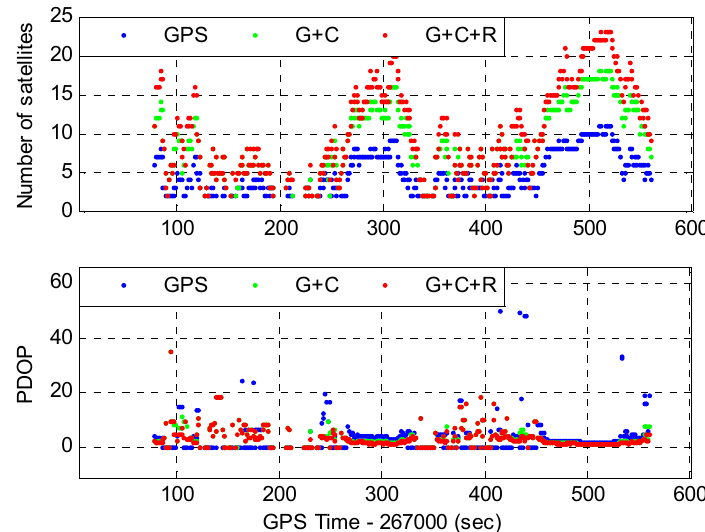
Figure 6. Number of visible satellites ( top ) and the corresponding PDOP ( bottom ) for the GPS, GPS + BDS (G + C), and GPS + BDS + GLONASS (G + C + R) systems.